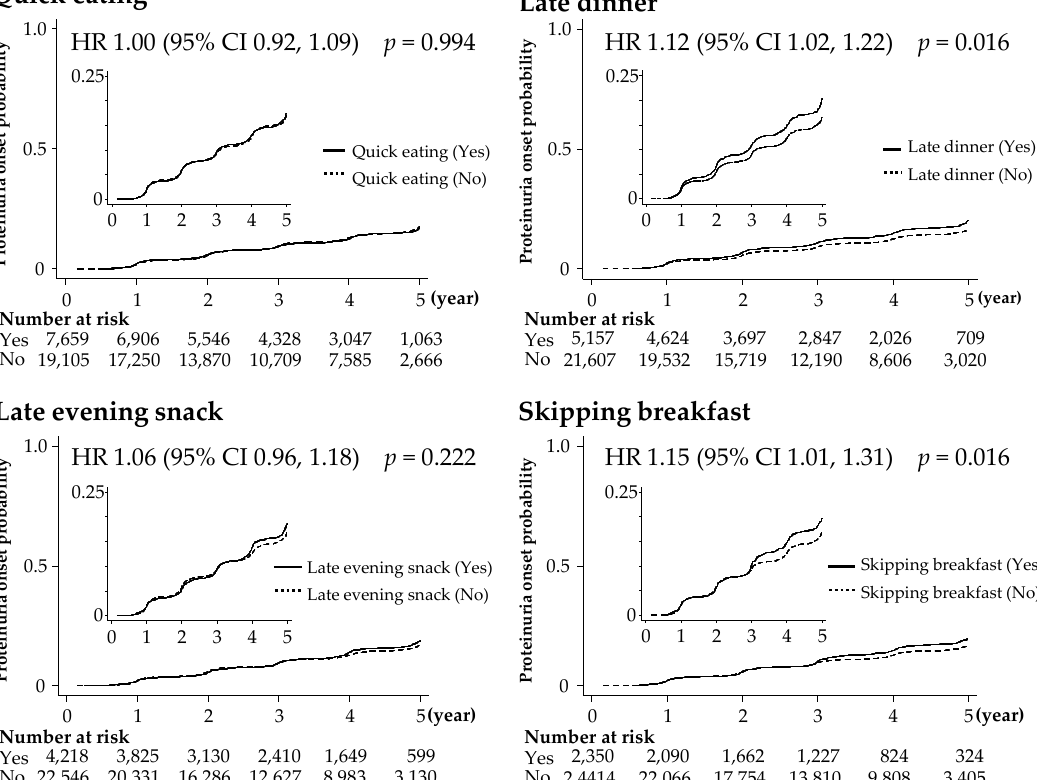
Figure 3. Kaplan–Meier curves and hazard ratio of proteinuria onset for each unhealthy dietary habit. Hazard ratios were adjusted for age, sex, body mass index, systolic blood pressure, estimated glomerular filtration rate, hemoglobin, triglyceride, total cholesterol, HbA1c, serum uric acid, daily drinking, and current smoking. The insets show the same data on enlarged y-axes. HR, hazard ratio; CI, confidence interval.